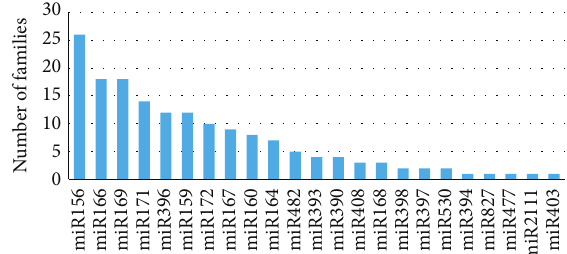
Figure 3: Number of family members of conserved miRNAs are represented as bar diagram.